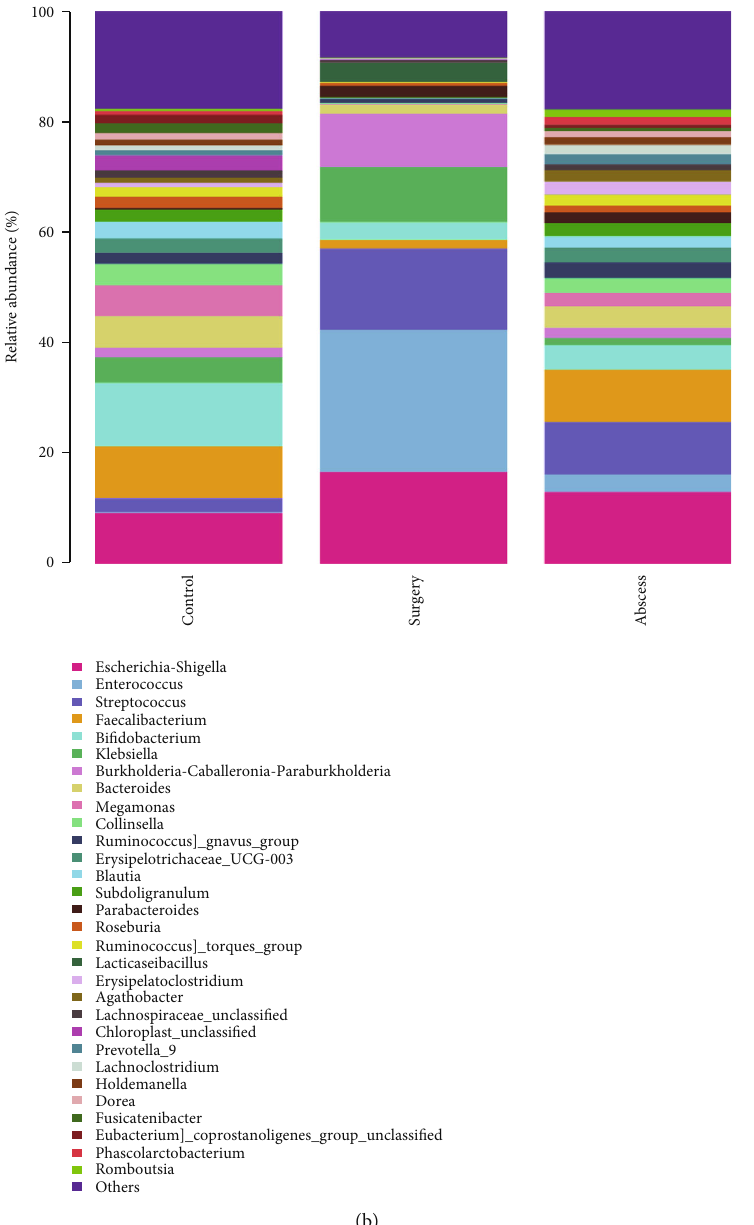
Figure 5: Relative abundance of bacteria at (a) phylum level and (b) genus